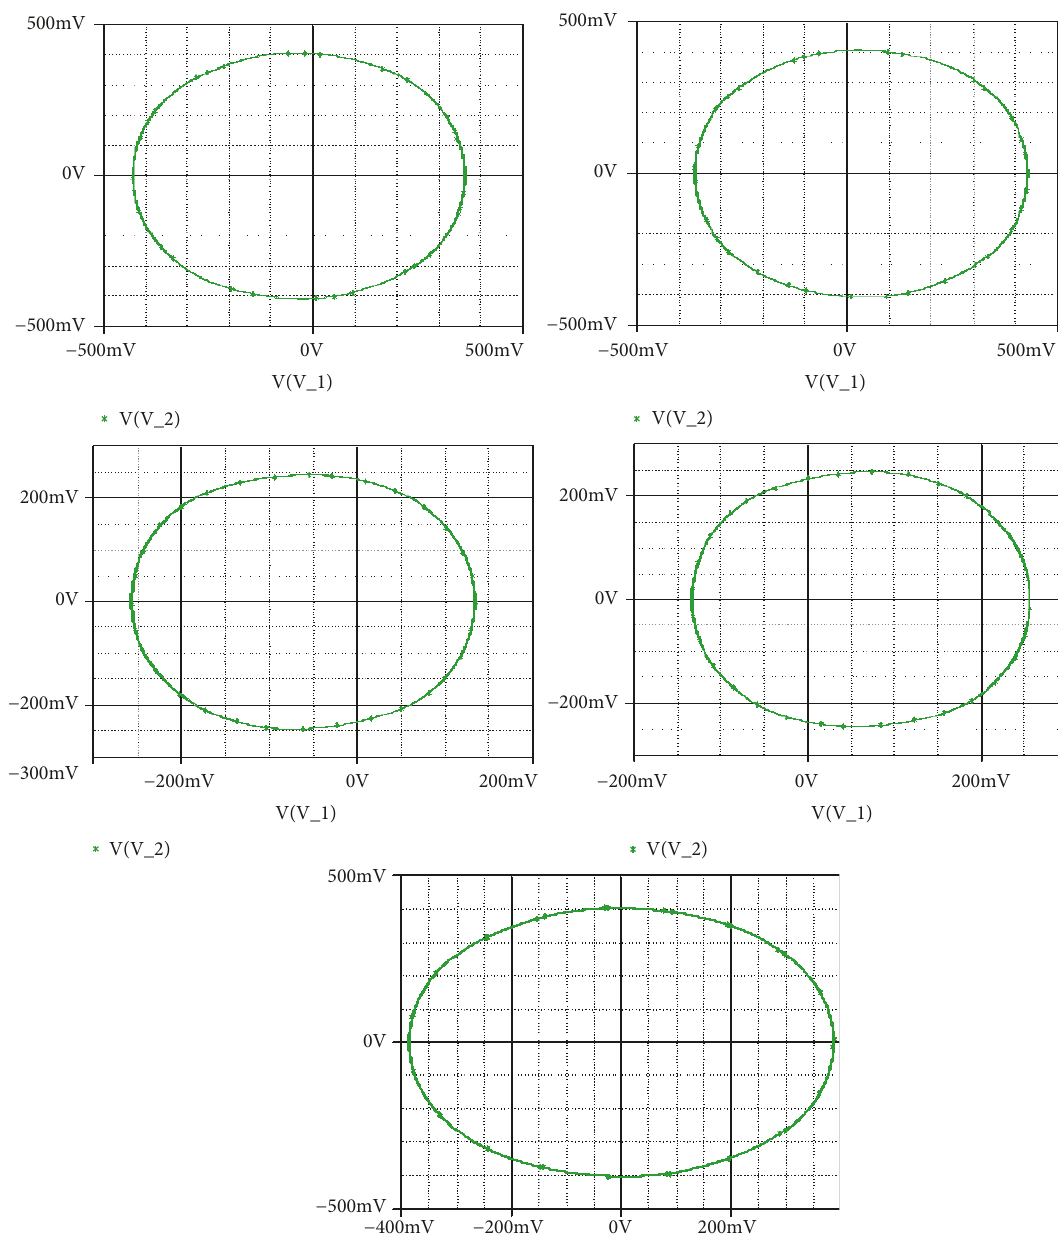
Figure 15: Pspice simulation results showing the coexistence of five different attractors for 𝑅𝑎2 = 14.65𝑘Ω (a pair of chaotic attractors, a pair of period-1 limit cycle, and a symmetric chaotic attractor). Initial states are indicated in Table 1.